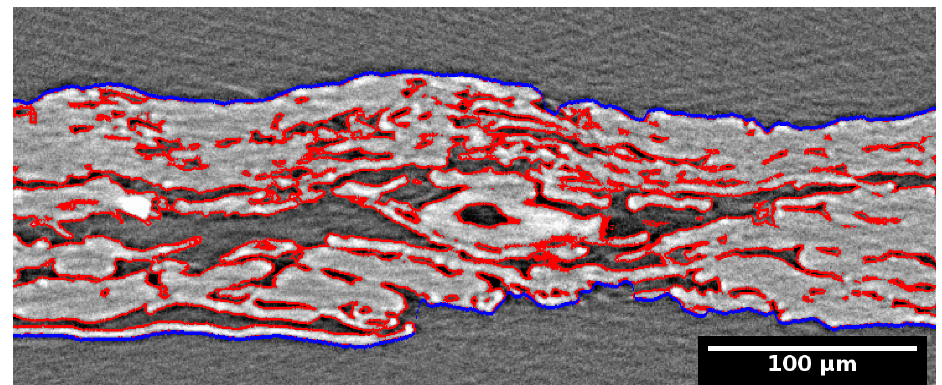
Figure 2. Visualisation of the X-ray microtomograph (CT) image of a sample pressed at 190 °C temperature (grayscale), edges of segmented regions (red) and surfaces of the sheet (blue).